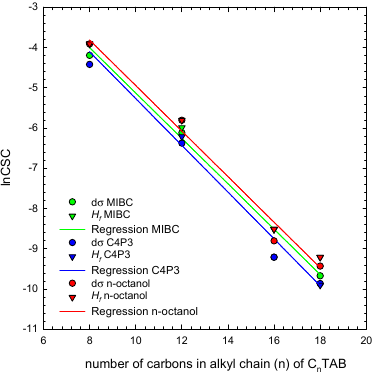
Figure 5. Correlation between H f lnCSC and d σ lnCSC values determined for n-alkyltrimethylammonium bromides homologs (C n TAB) in mixture with non-ionic SAS.